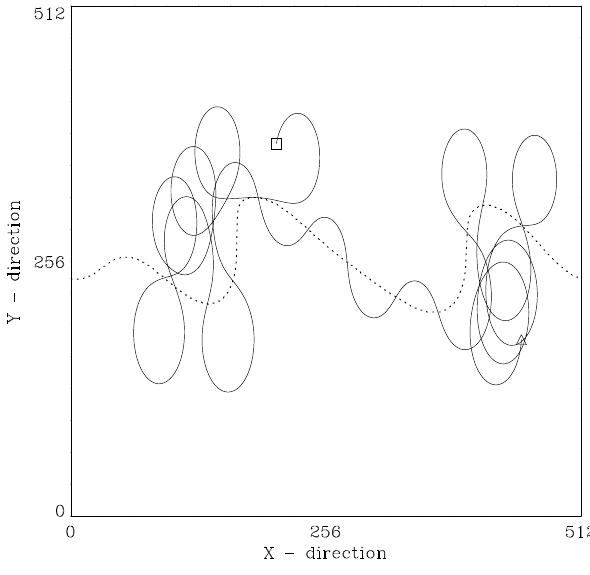
Fig. 11. Particle orbit crossing the interface. The particle starts in the MSP (square) and ends up in the MSH (triangle). Both Speiser- like and figure eight-like sequences can be